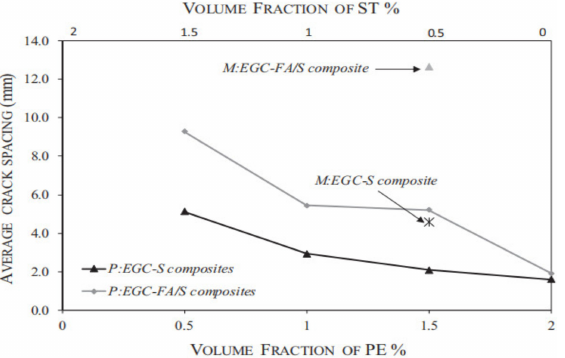
Figure 7. Average crack spacing versus PE and ST fiber volume fractions [69]. Adapted with permission from [69], copyright 2018